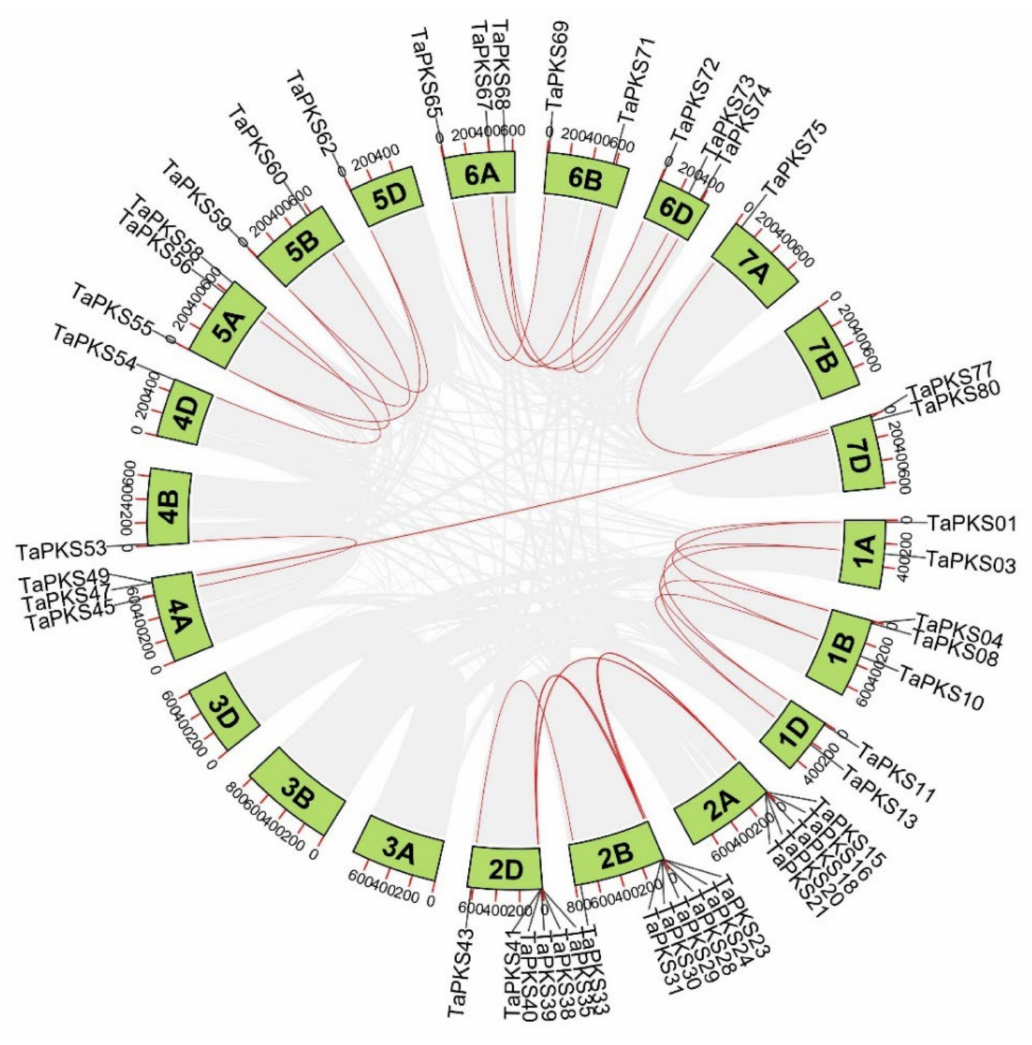
Figure 4. Chromosomal distribution of PKS segmental duplication genes in wheat. The gray lines in the background represent the segmental duplication in the whole wheat genome. Red lines represent PKS gene pairs with segmental